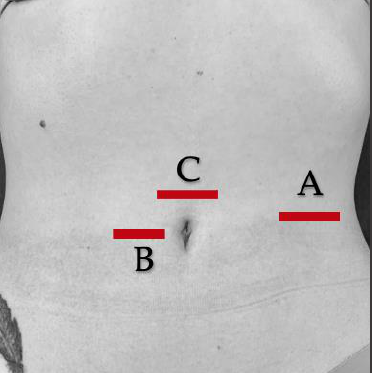
Figure 5. Reference points for the RUSI images [47,50]. ( A ) Midway between ASIS (antero superior iliac spine) and the last rib, on the midaxillary line, to obtain images of the TrA, IO, and EO muscles. A horizontal line was drawn 2 cm lateral to the TrA insertion in the RA connective tissue as a reference for TrA, IO, and EO measurements at rest and during muscle contraction; ( B ) Midway along the RA muscle at the level of the umbilicus, transverse to acquire the RA image. The reference point for RA thickness measurement was the mean distance of the width of each RA; ( C ) In the middle of the abdomen, a distance of 2 cm above the umbilicus to measure IRD.